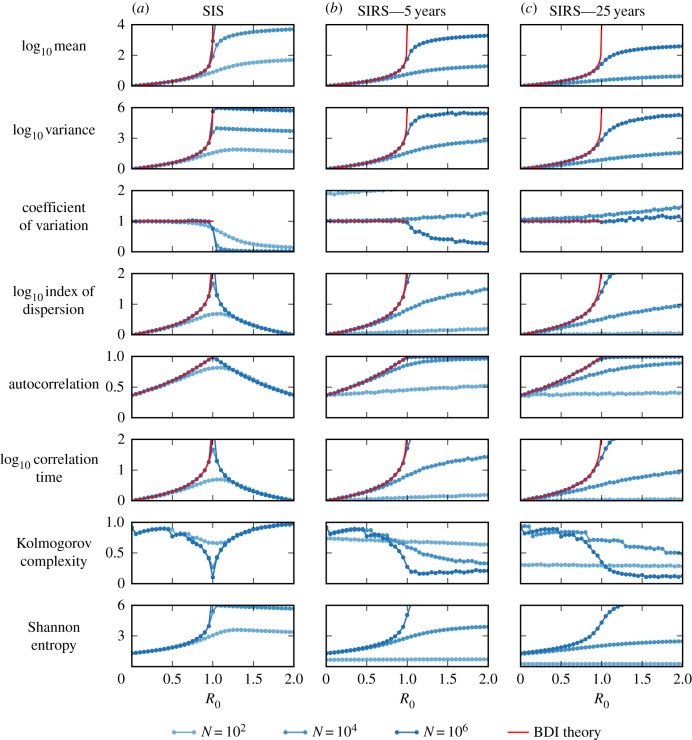
EWS for the stationary SIS and SIRS models. Red lines correspond to the theoretical results found from the BDI model (table 1). Symbols depict the results of simulations with the duration of immunity as indicated in the figure. Independent simulations are performed for each value of R0. EWS are calculated by time averaging over 4 × 103 weeks of data (see appendix D). The force of infection in the SIS and SIRS models is λ = (βn + ζ)/N, where n is the number of infected and N the total population size. The remaining model parameters are γ = 1 and ζ = 1 week−1. The autocorrelation is calculated at lag one week, AC(1). (Online version in colour.)